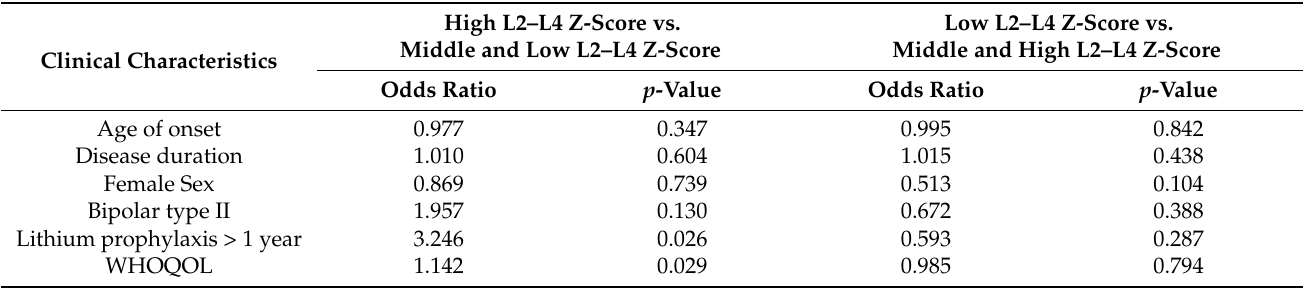
Table 4. Z-scores in relation to clinical characteristics, logistic